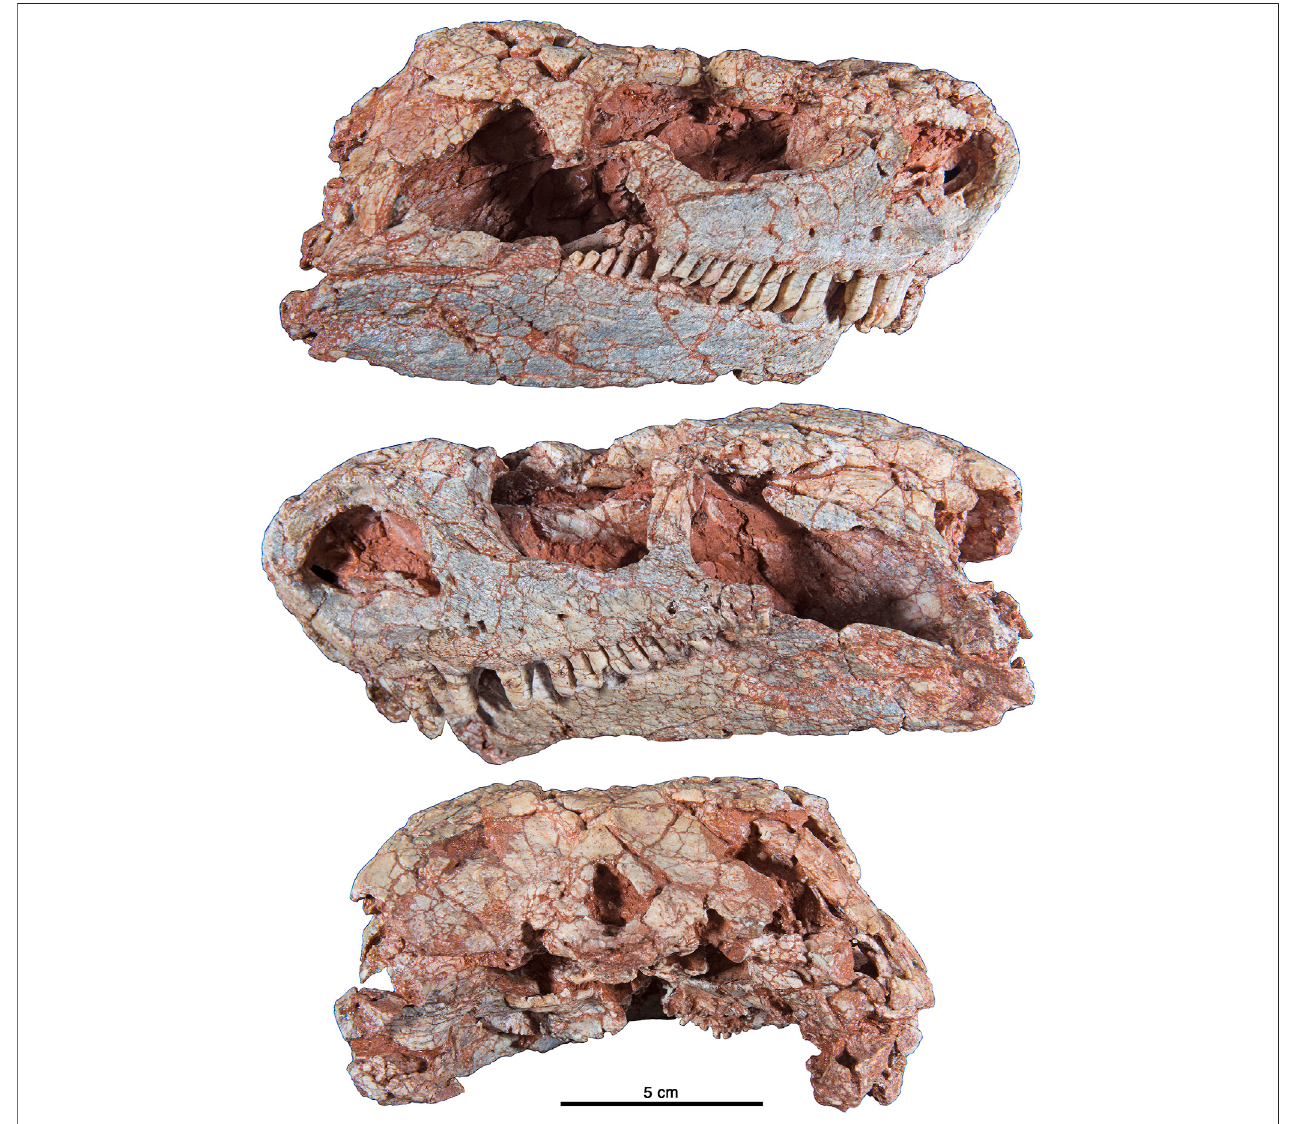
FIGURE 2 | Cotylorhynchus romeri , OMNH 04329, referred specimen. Photographs in lateral and occipital views.